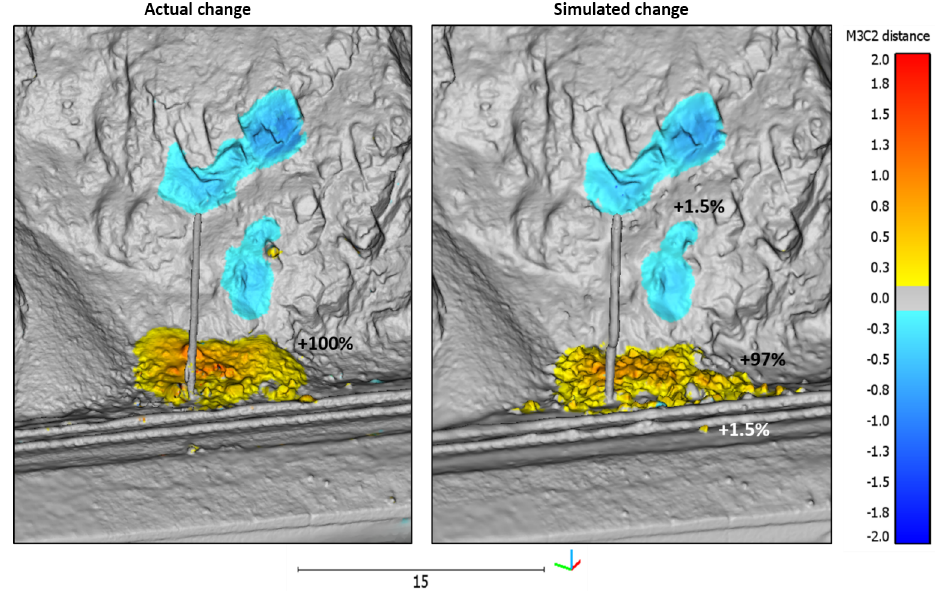
Figure 17. A comparison of the actual and simulated change detection results from the 8m 3 planar sliding event from White Canyon West, Site E. The simulation produced a good comparison with the actual change detection results, yielding a similar spatial distribution and magnitude of change. The percentage of initial source volume retained at various locations on the actual and simulated slope is shown. The majority of the material in both cases is retained in the track-side ditch. In the simulated case a small amount of the simulated volume comes to rest on the slope (1.5%) and runs out into the track area (1.5%).